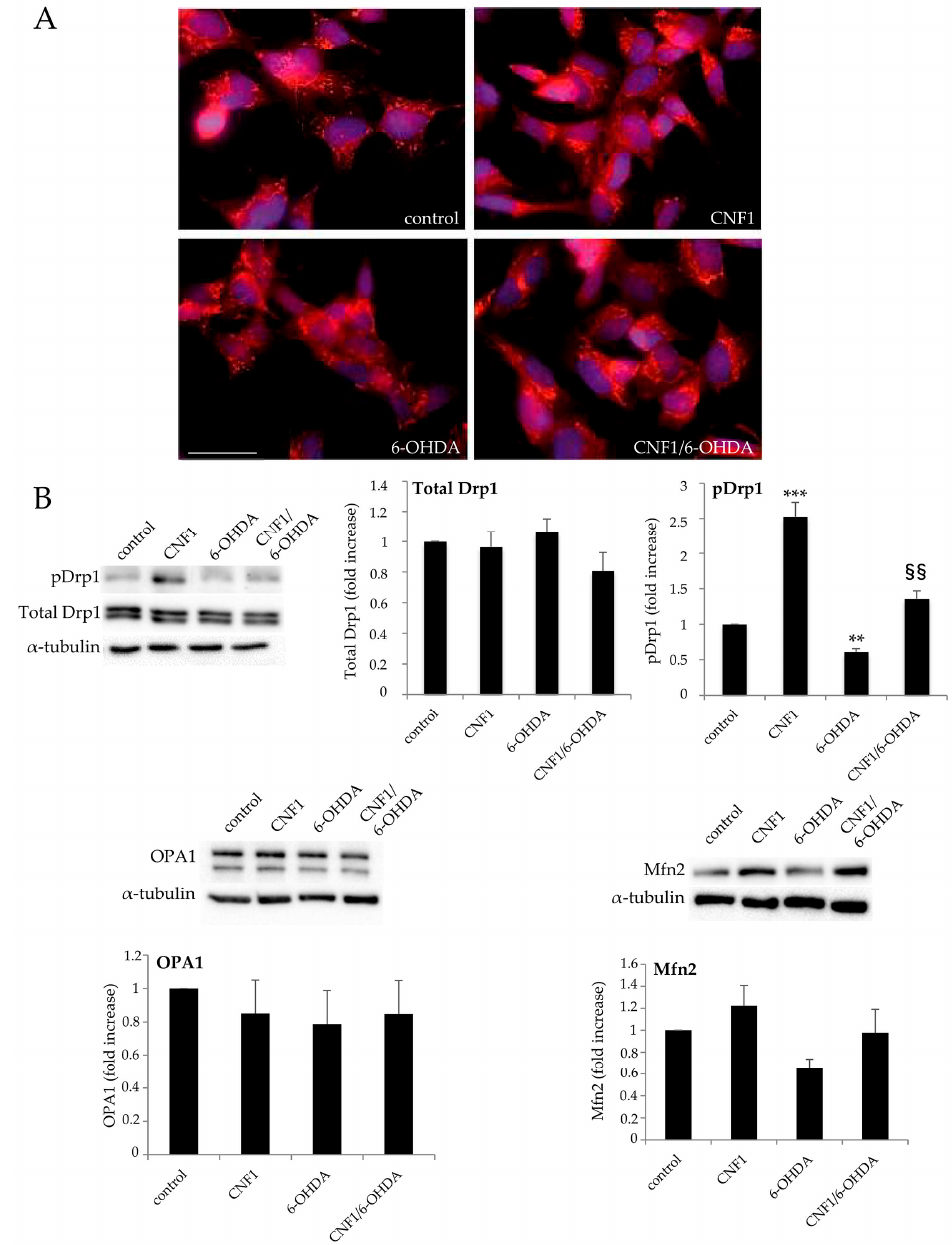
Figure 2. CNF1 influences mitochondrial morphology and dynamics in SH-SY5Y cells. ( A ) Fluorescence microscopy micrographs of SH-SY5Y cells in the di ff erent experimental conditions, co-stained with the mitochondrion-selective dye MitoTracker (red) and with the nuclear dye Hoechst 33258 (blue). Note that pre-treatment with CNF1 counteracts the neurotoxin-induced mitochondrial fragmentation, promoting an enrichment of the mitochondrial network, either in control or in 6-OHDA treated cells. Bar = 10 μ m. ( B ) Western blot analysis in whole-cell lysates of proteins involved in mitochondrial fusion / fission proteins. The amounts of OPA1, Mfn2 and total Drp1 are normalized as a function of α -tubulin, while the amount of pDrp1 is normalized as a function of total Drp1 (histograms). Note that CNF1 dramatically increases pDrp1 expression in control cells and counteracts the reduction of the phosphorylated protein in cells challenged with 6-OHDA. The graphs report the mean ± SEM from three di ff erent experiments. For each protein, results are expressed as fold increase relative to control ( = 1). *** p < 0.001 compared with control; ** p < 0.01 compared with control; §§ p < 0.01 compared with